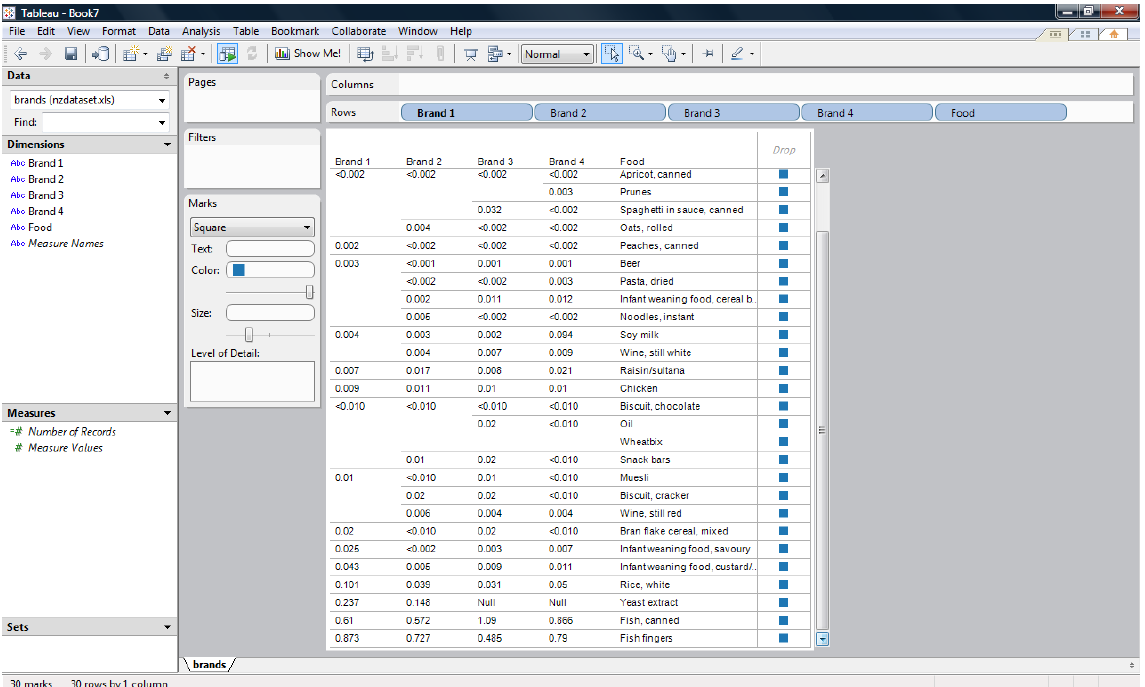
Figure 2. Screenshot of visual analytics interface for grouping arsenic content (mg/kg) of foods from a study in New Zealand a . Visual Analytics process revealed relationship between Oil and